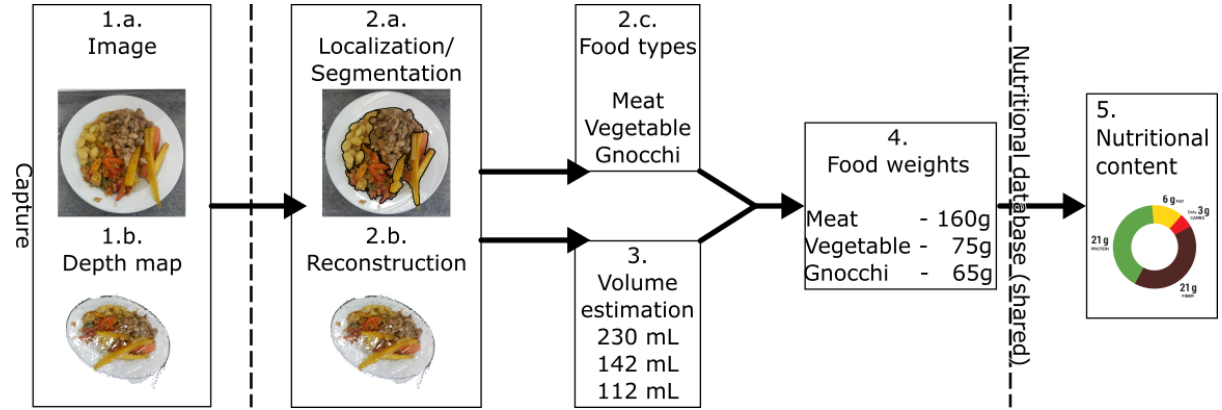
Figure 1. Automated food quantification workflow performed by the SNAQ